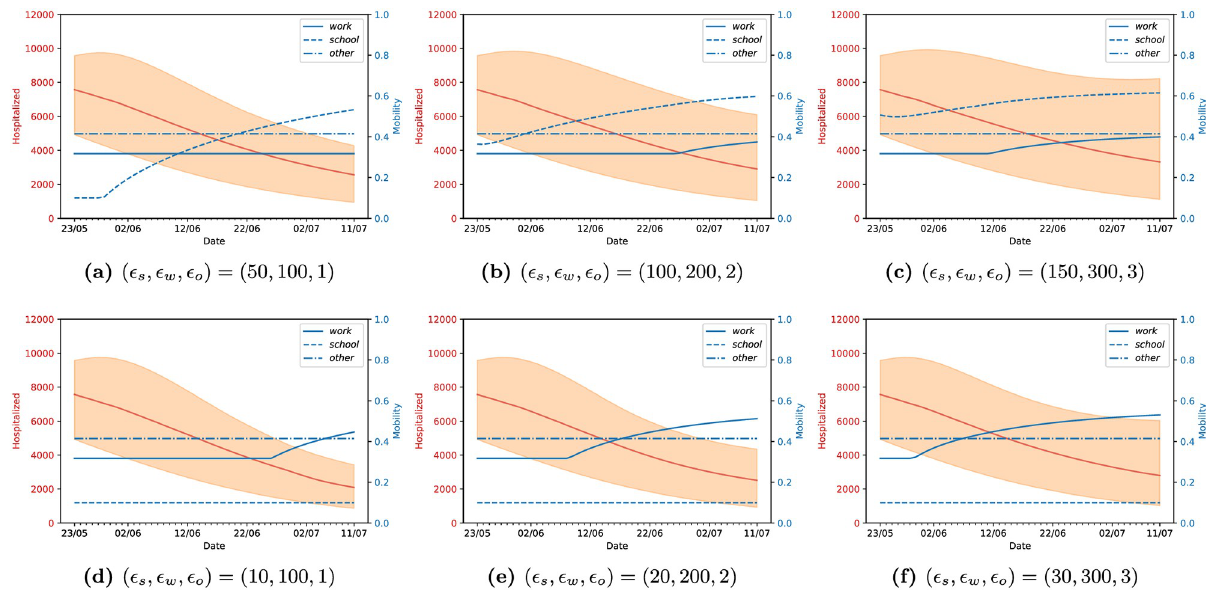
Fig 9. Different economic cost weights produce different opening strategies and predicted hospitalized people, with lockdown strategies starting on the 24th of May and applied for T h = 120 days, for England.